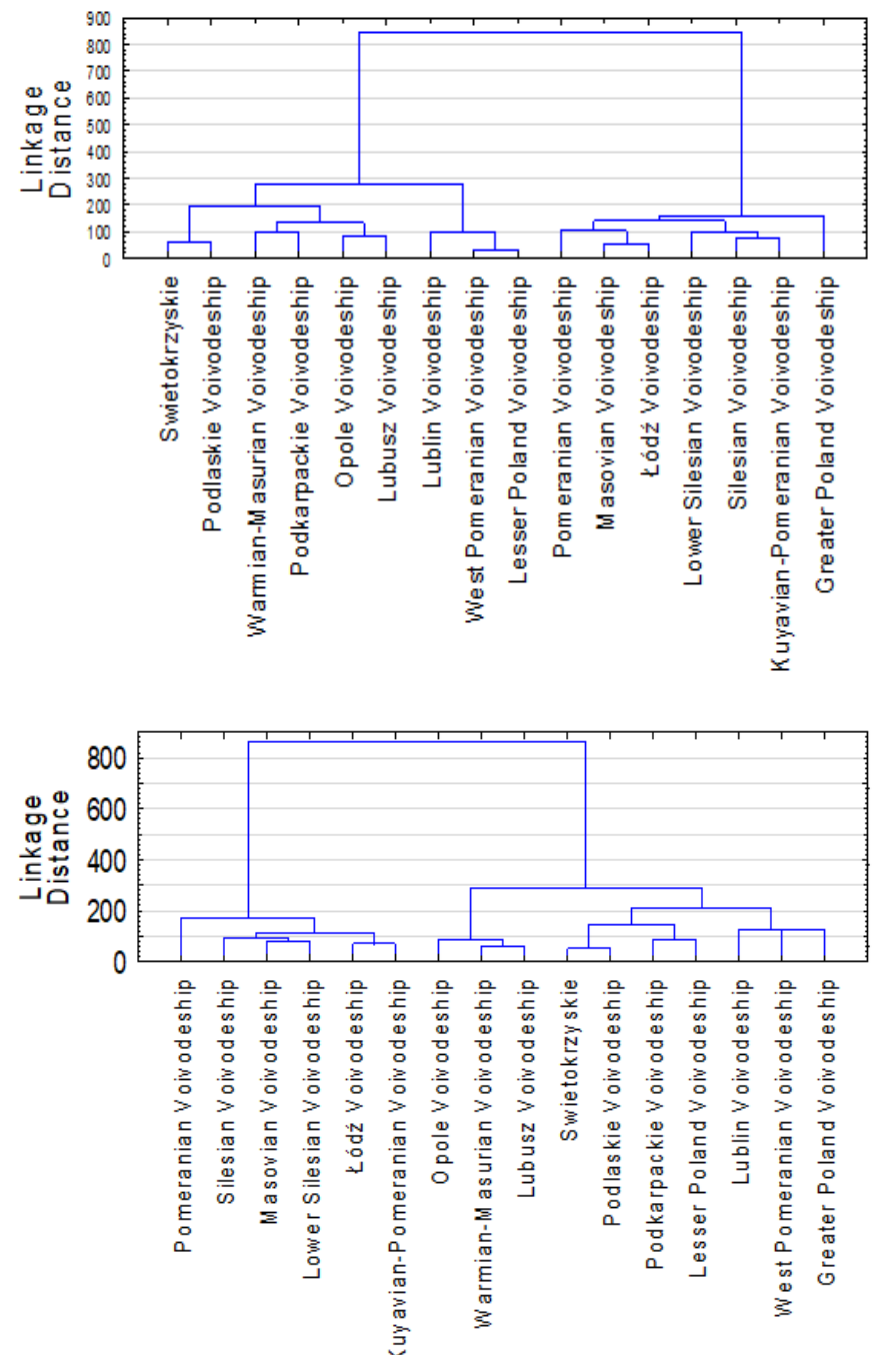
Figure 1. Poland ’ s hierarchical clustering for the pre-pandemic ( top ) and pandemic period ( bottom ).